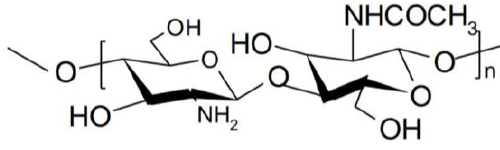
Figure 1. Structure of chitosan.